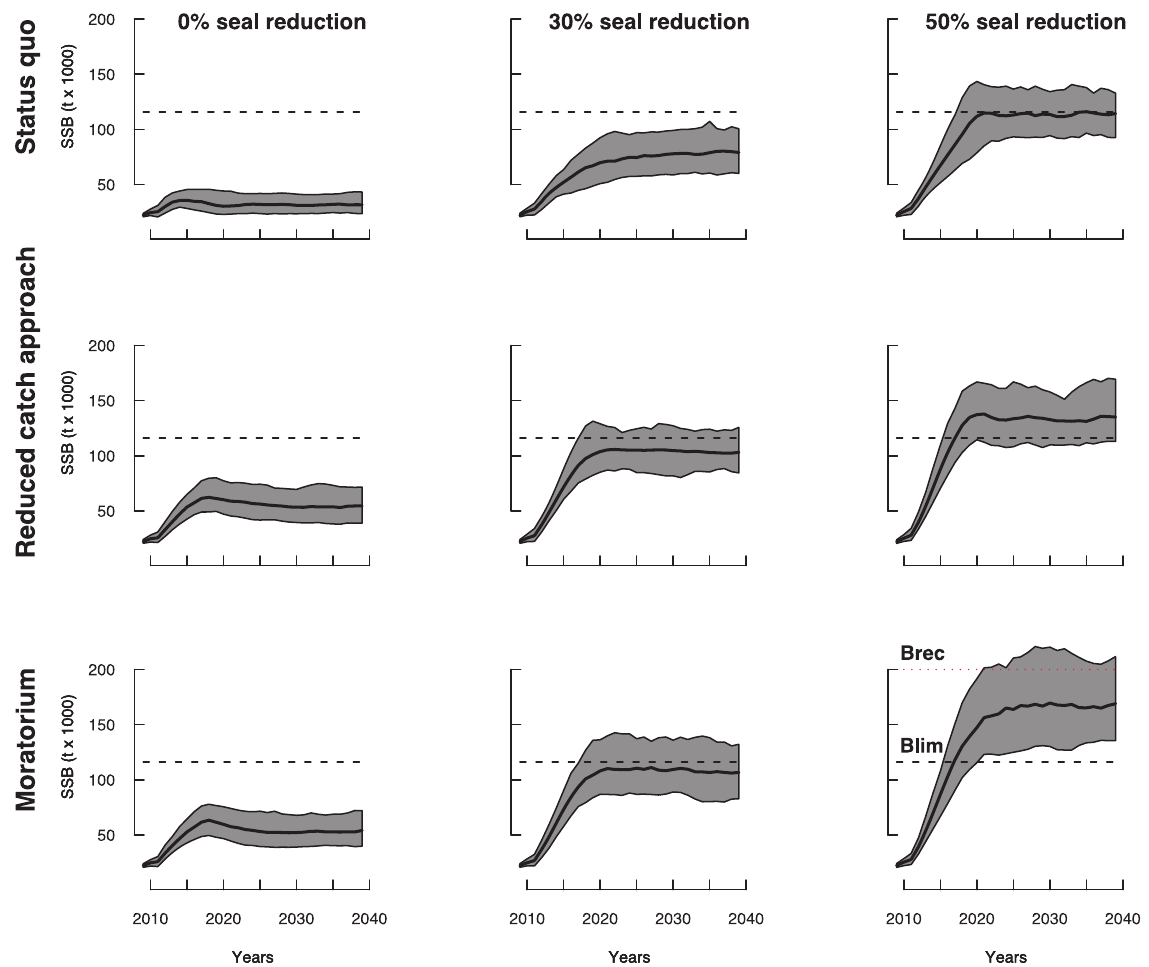
Figure 4. Cod SSB forecast in years 2010–2040 under water standard conditions (cold intermediate layer (CIL) anomaly =0.25 u C). Plain lines and grey areas indicate median values and 90%-confidence domains, respectively. The dashed line indicate the limit of recruitment overfishing B lim . The red dotted line indicates the complete recovery point B rec . (Figure 7). After 2020, a statistically-significant separation appeared between the confidence intervals. The moratorium approach reduced the time for recovery, while the reopening of fishing through the reduced catch approach would have the effect of reducing the SSB during the following 10 years.